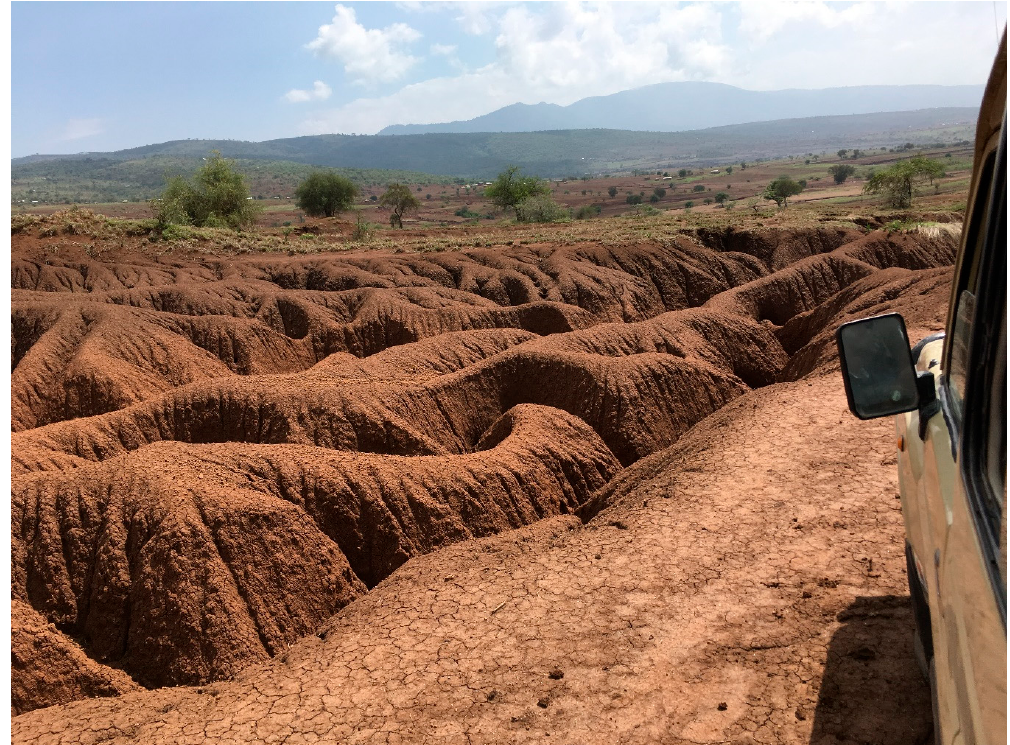
Figure A1. Severe gullying, Monduli District, Tanzania. Source: Authors. Land 2020 , 9 , x FOR PEER REVIEW